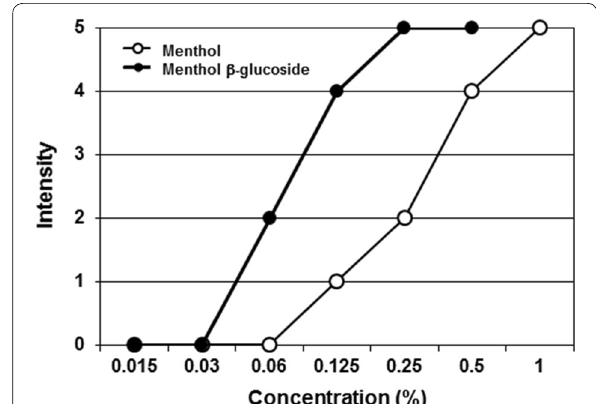
Fig. 4 Topical testing of ( )‑menthol β‑ d ‑glucoside and ( )‑menthol − − on the inside of the forearm. The cooling effect on the skin was deter‑ mined using a topical test that scored the cooling intensity on a scale from 0 (no effect) to 5 (very strong)